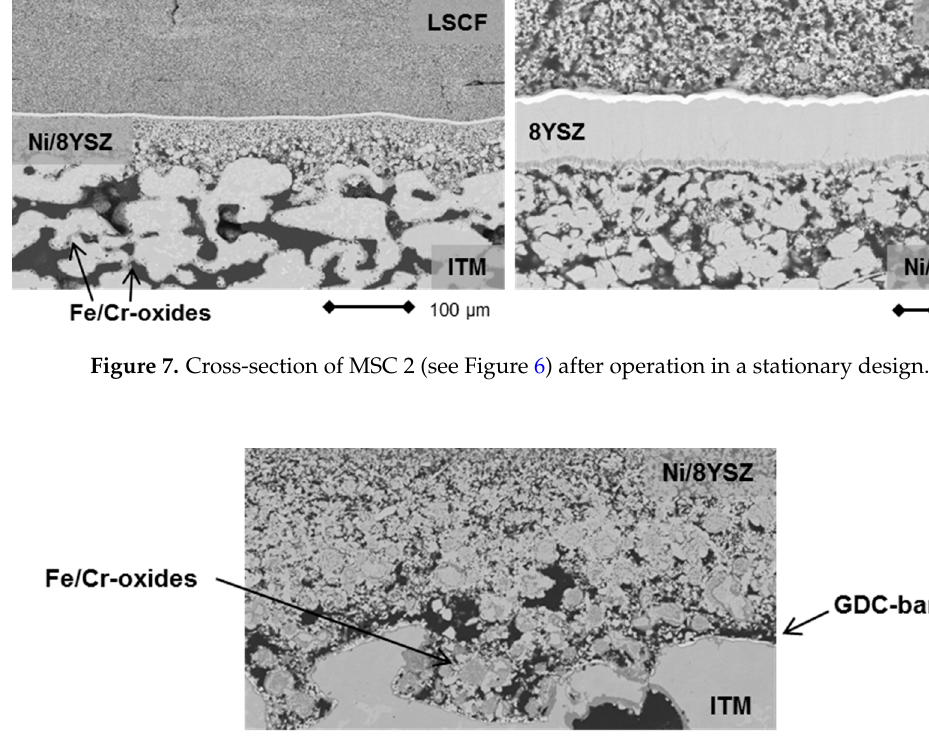
Figure 8. Cross-section of MSC 2 after operation in a stationary design exhibiting interdiffusion phenomena at contact interface between substrate/DBL/anode. These interdiffusion phenomena may have been caused by insufficient stability of the barrier material GDC under the applied conditions. Indeed, it has been reported previously that doped cerates are prone to oxygen loss and phase transformation under highly reducing atmospheres, which enables interaction with neighboring materials or even decomposition [32]. Higher performance degradation rates, compared to full ceramic SOFCs, are a relatively common phenomenon for MSCs and have been reported for various cell concepts by other groups [13,21,33–35]. Reasons for this are in part the presence of the porous steel support, which may oxidize or coarsen during operation and can, at least in part, interact with the catalytically active centers of the anode (usually Ni). By applying a suitable and more redox-stable barrier layer, the expected lifetime of the MSC will increase significantly, while electrical properties remain largely unaffected. 3. Materials and Methods 3.1. Cell Design and Manufacturing The cell design is presented schematically in Figure 9. The first step in the production cycle is the manufacturing of the 0.8 mm thick porous metal support (Cr26-Fe, ITM) by a powder-